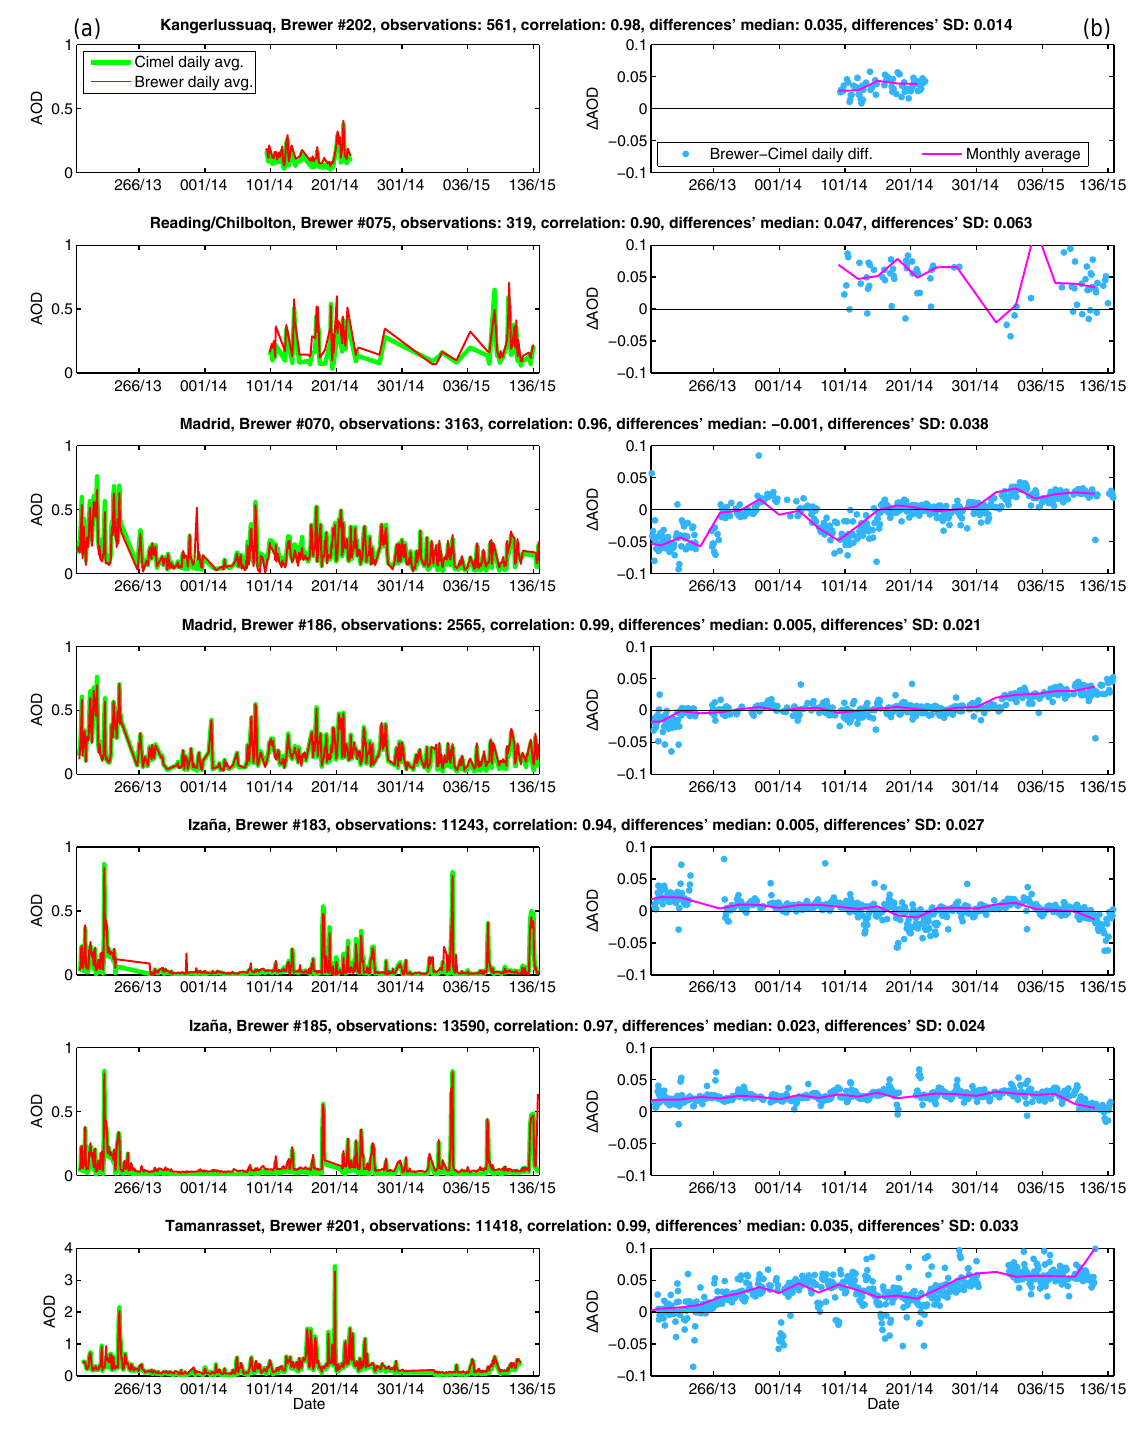
Figure 3. Brewer and Cimel AOD for the 2013–2015 period. AOD series shown in the (a) panels correspond to daily averages calculated from Brewer (red) and Cimel (green) observations within 1min. Daily (blue) and monthly (magenta) averages of AOD differences are shown in (b) . For the Brewer we use the data for the longest measured wavelength at 320.1nm, and for the Cimel, the 340nm AERONET level 2.0 product extrapolated to 320nm using the 340–440 Ångström exponent. Note that Brewer #075 operating at Reading is compared to the Cimel sun photometer operating at Chilbolton. The y axes of the figures on the left go up to 1 in all cases except Tamanrasset, for which it reaches a value of 4. Dates on the x axes are shown in DOY/YY format, where DOY is day of